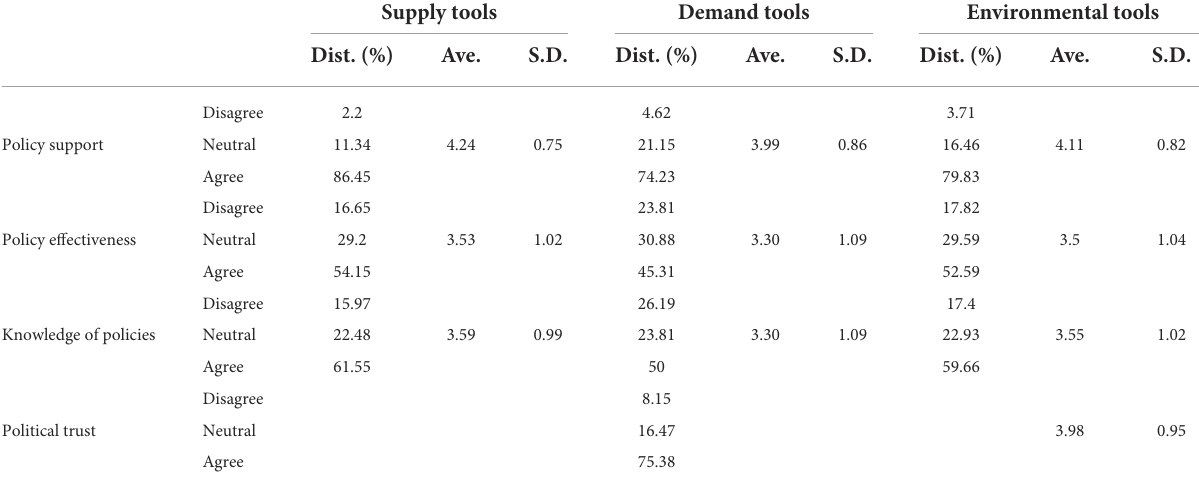
TABLE 5 Distribution of key variables for the three policy tools.